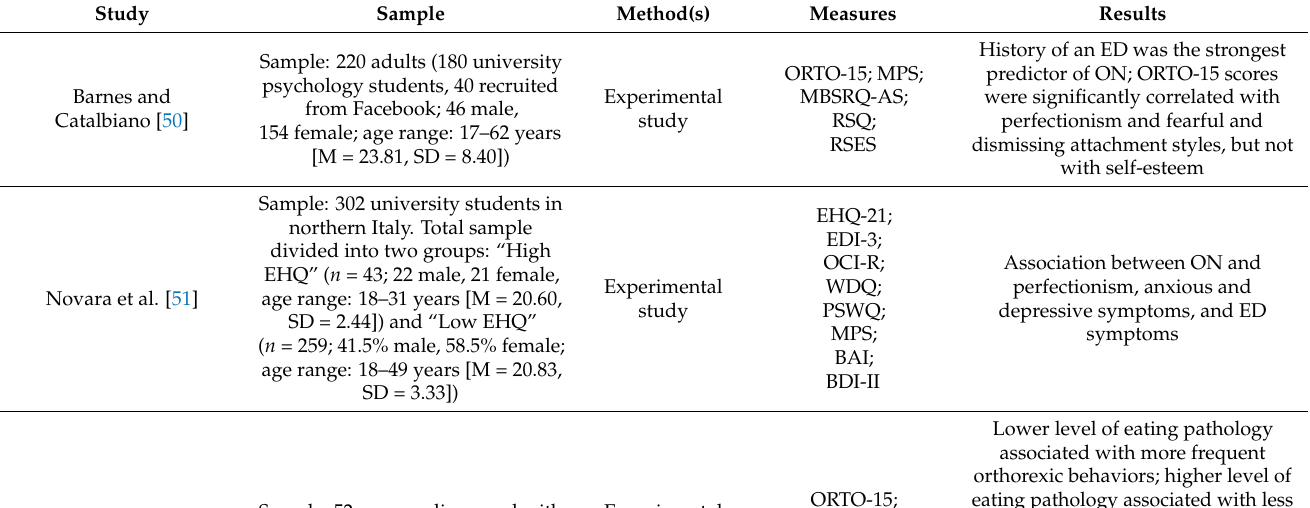
Table 2. Methodologies and results of the investigated